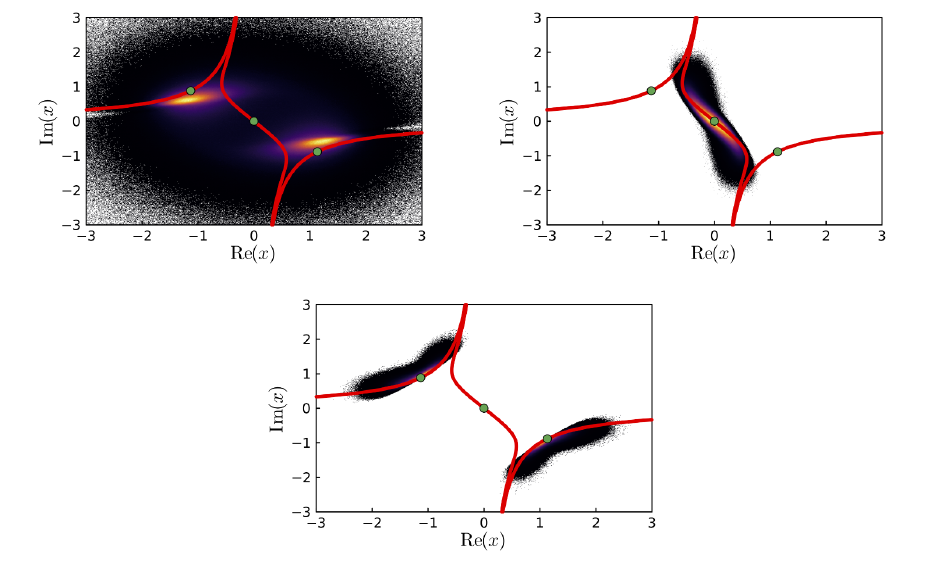
Figure 12 . Distribution of the complex Langevin simulation and the Lefschetz thimbles (red line) for the model of eq. (B.1) with σ = − 1 + 4 i and λ = 2 , using different kernels; K K 3 = e − i 3 π 4 (top right) and K 4 = e i π 2 (bottom). The green points are the critical points given by the solution to eq.